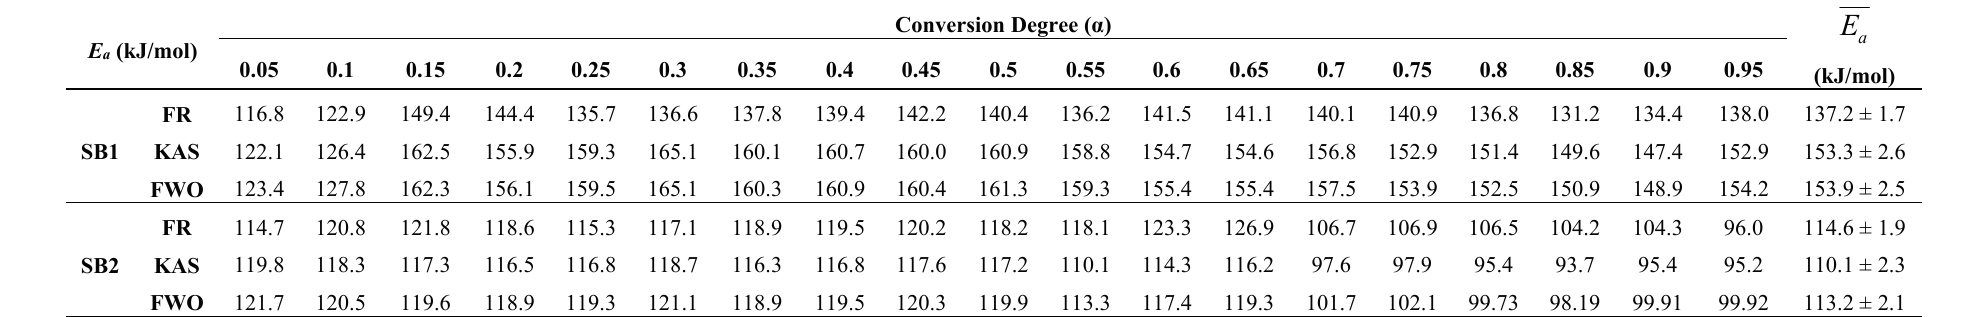
Table 1. The obtained values for activation energies by the three isoconversional methods for the new Schiff